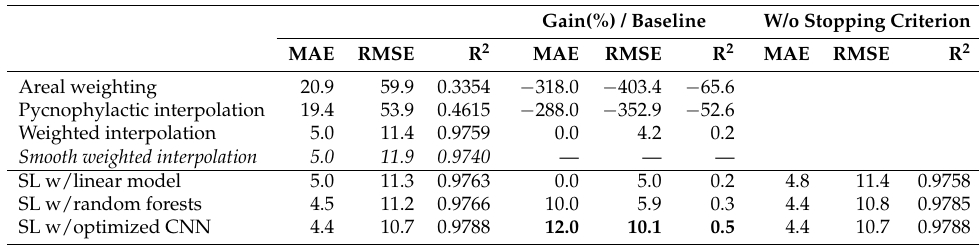
Table 12. Results obtained with the self-training approach using different regression algorithms for the number of live